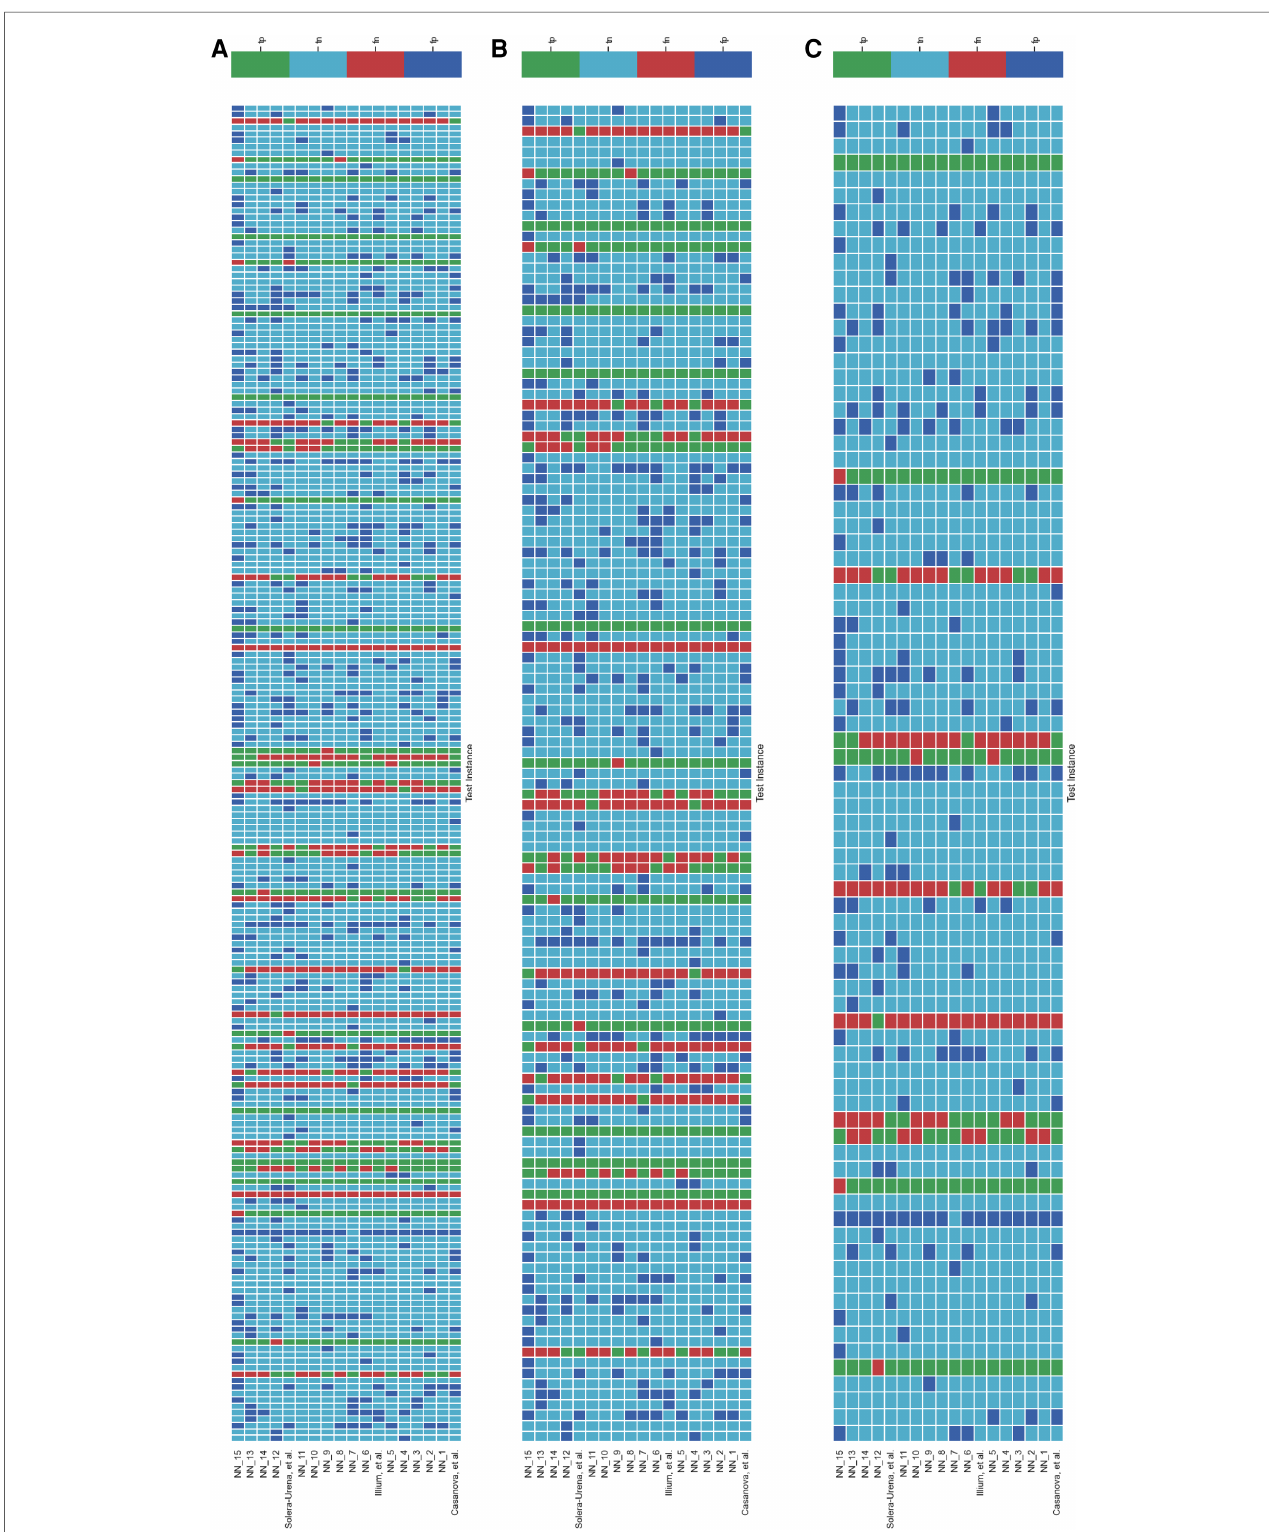
FIGURE 5 Schematic detailing the level of agreement between teams for each test instance for the COVID-19 Cough Sub-Challenge . Each row represents a team ’ s submission results. The teams have been ordered by Unweighted Average Recall, from the bottom up (team Casanova et al. ’ s predictions represent the highest scoring submission). Each column represents all teams predictions, across the competition, for one test instance. The test instances appear in the order in which they are in the test set. ( A ) Details all the test instances, ( B ) details only the test instances which were experiencing symptoms at the time of recording, and ( C ) details only the test instances which were experiencing no symptoms at the time of